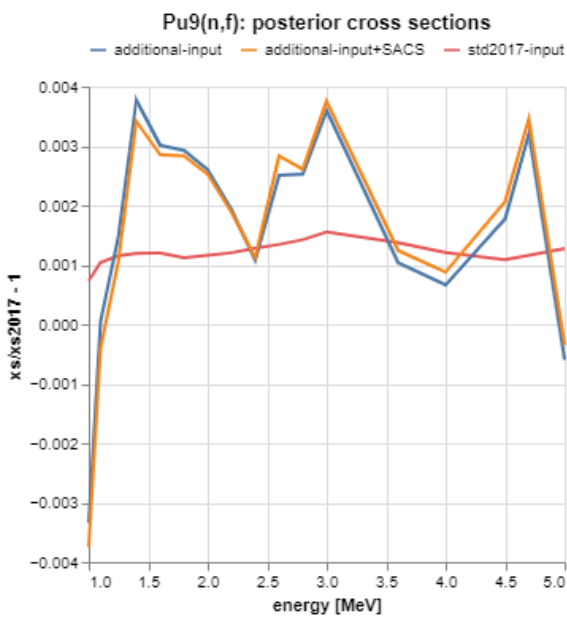
Figure 3: Evaluated 239 Pu(n,f) cross sections relative to the IAEA STD 2017[3] from 1 MeV up to 5